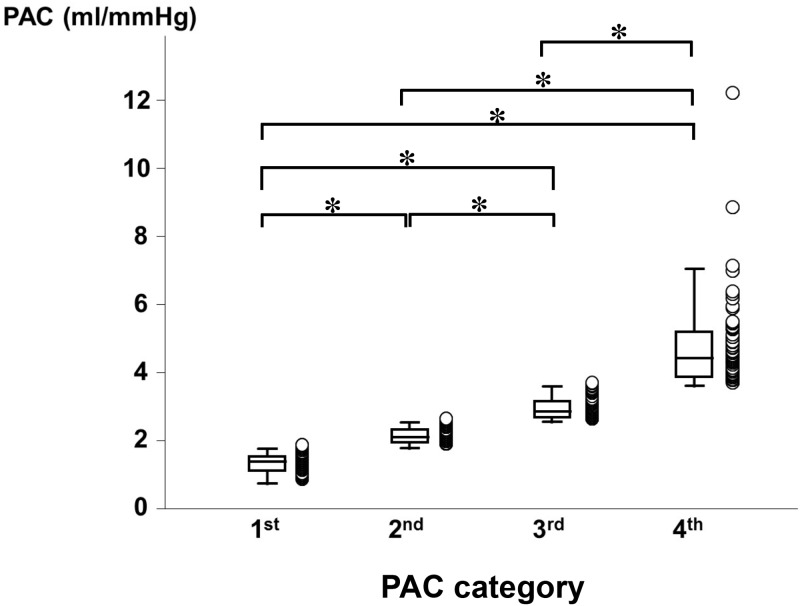
Distribution of PAC in each quartile.PAC, pulmonary arterial capacitance. * P<0.001.